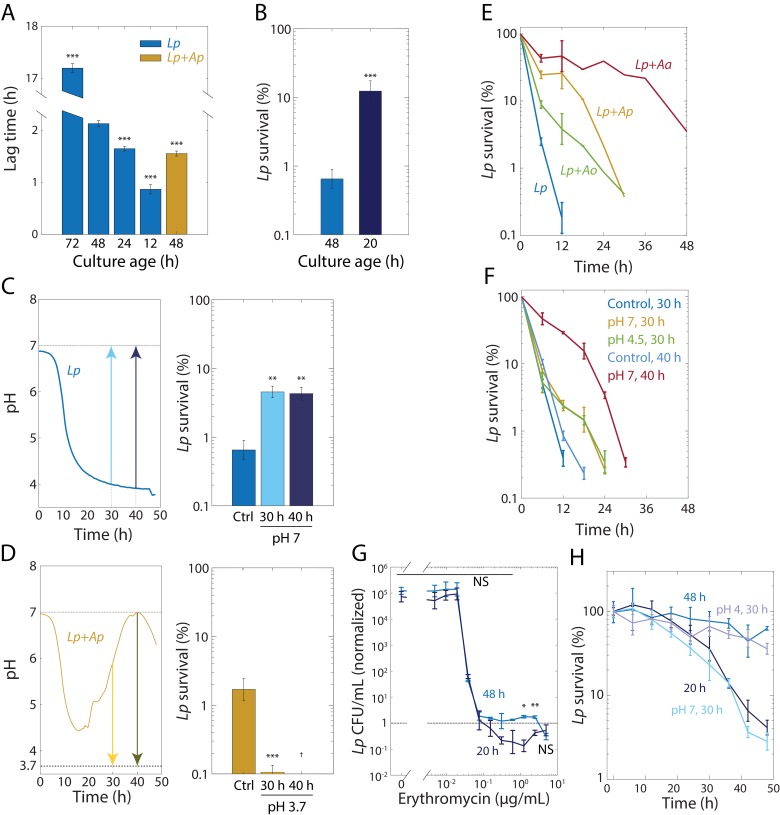
Tolerance to rifampin is modulated by pH.(A) The duration of lag phase of bulk cultures of Lp depends on the time spent in stationary phase. Lp monocultures grown for various times from OD = 0.02, and co-cultures with Ap, were diluted into fresh medium. Lag time was calculated by fitting growth curves to the Gompertz equation. Error bars are standard deviation (S.D.), n = 12. p-values are from a Student’s two-sided t-test of the difference with respect to the 48 h culture (***: p<2.5×10−4, equivalent to ***: p<1×10−3/n, where n = 4 is the number of comparisons). (B) Culturing Lp as a monoculture for a shorter time leads to higher cell survival. Viable cell plating counts of Lp after growth in 20 µg/mL rifampin for 24 h normalized to the counts at the start of the experiment (t = 0). Error bars are S.D. for each condition, n = 3. p-values are from a Student’s two-sided t-test of the difference between the cultures (***: p<1×10−3). (C) Neutralization of pH in stationary phase in Lp monocultures is sufficient to induce tolerance. Increasing the pH of an Lp monoculture at t = 30 h or t = 40 h to 7 to mimic the pH increase in co-cultures of Lp with Acetobacter species (upper panel) increased cell survival (CFU/mL normalized to counts at the start of the experiment, t = 0) after treatment with 20 µg/mL rifampin for 24 h (lower panel). A 48-h-old culture with no changes in pH was used as a control (Ctrl.). Error bars are S.D. for each condition, n = 3. p-values are from a Student’s two-sided t-test of the difference between the cultures (**: p<5×10−3, equivalent to **: p<0.01/n, where n = 2 is the number of comparisons). (D) Acidification of Lp co-cultures with Ap during the exponential-to-stationary phase transition or in late stationary phase sensitizes Lp to rifampin. Decreasing the pH of an Lp co-culture with Ap at t = 30 h or t = 40 h to 3.7 to mimic the pH of an Lp monoculture (upper panel) increased survival (CFU/mL normalized to counts at the start of the experiment, t = 0) after treatment with 20 µg/mL rifampin for 24 h (lower panel). Error bars are S.D. for each condition, n = 3. p-values are from a Student’s two-sided t-test of the difference between the cultures (***: p<5×10−4, equivalent to ***: p<1×10−3, where n = 2 is the number of comparisons). †: values below the limit of detection. (E) The dynamics of killing in Lp co-culture with Acetobacter species differs quantitatively according to species and from Lp monoculture (blue), indicating that the Acetobacter species induce rifampin tolerance to different degrees. CFU/mL of Lp in monoculture and in co-culture with Acetobacter species, and treated with 50 µg/mL rifampin, normalized to counts at the start of the experiment (t = 0). Error bars are S.D. for each condition, n = 3. (F) The timing of the pH change in Acetobacter co-culture predicts the extent of protection against 50 µg/mL rifampin. Neutralization of pH in Lp monocultures at 40 h of growth (to mimic Lp+Aa co-cultures) elicits longer protection against rifampin than neutralization at 30 hr. A small increase in pH (from 3.85 to 4.5) at 30 h (to mimic Lp+Ao co-cultures) provides protection comparable to complete neutralization. CFU/mL were normalized to counts at the start of the experiment (t = 0). Error bars are S.D. for each condition, n = 3. (G) Lp survival to erythromycin is ~10 times higher after 24 h of treatment with erythromycin at supraMIC concentrations for 48-h-old monocultures of Lp than for 20-h-old Lp monocultures. Viable cell plating counts of Lp after growth in erythromycin for 24 h normalized to cell counts at the start of the experiment (t = 0). Error bars are S.D., n = 3. p-values are from a Student’s two-sided t-test of the difference between the two samples at a given time point (*: p<4×10−3, **: p<8×10−4 equivalent to *: p<0.05/n, **: p<0.01/n, where n = 12 is the number of comparisons; NS: not significant). (H) Shifting the pH of an Lp monoculture at 30 h to 4 or 7, followed by 18 h of growth before treatment with 2 µg/mL erythromycin, mimics the survival dynamics of a 48-h-old or 20-h-old culture in stationary phase, respectively. CFU/mL of Lp monocultures were normalized to counts at the start of the experiment (t = 0). Error bars are S.D. for each condition, n = 3.